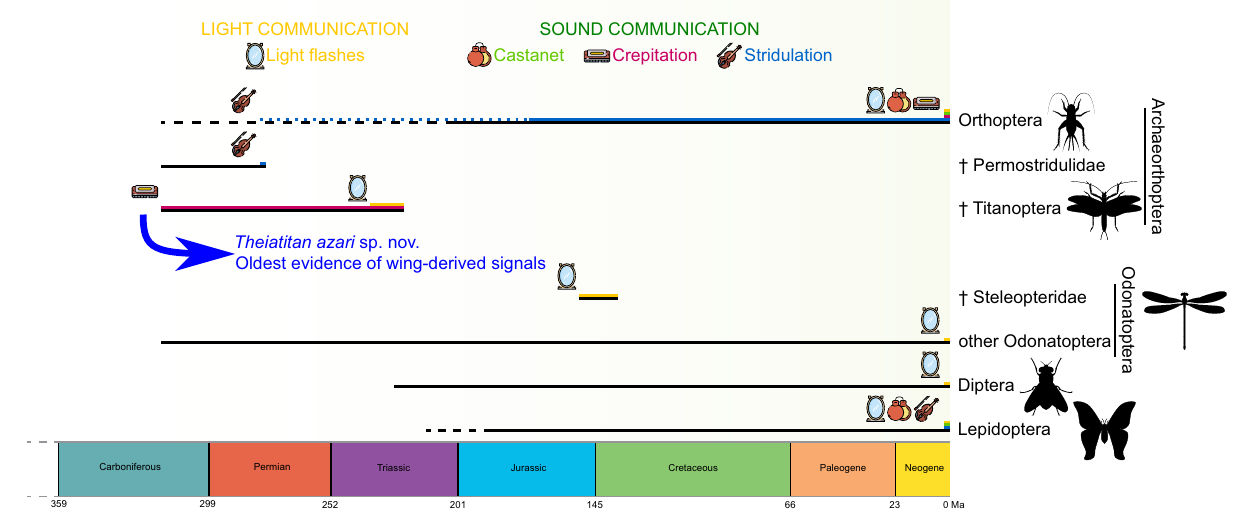
Fig. 8 Insect lineages using wings to produce light and/or sound. Theiatitan azari Schubnel, Roques & Nel, sp. nov. featured as oldest potential record of such a production. Only lineages with extinct species assumed to have produced sound or light with their wings are depicted, together with extant lineages that use those communication channels. Buzzing and lineages communicating with other structures, e.g., cicadas or fi re fl ies, are not considered. Ages of lineages derived from fossil records; dotted lines: stem-lineages. † symbolizes extinct taxa. Permian stridulating Orthoptera correspond to new, undescribed Chinese Ensifera (Huang et al., in prep.). Harmonica, mirror and violin icons from Open Access ‘ Freepik @ fl aticon ’ , castanet icon modi fi ed from Open Access ‘ Good Ware @ fl aticon ’